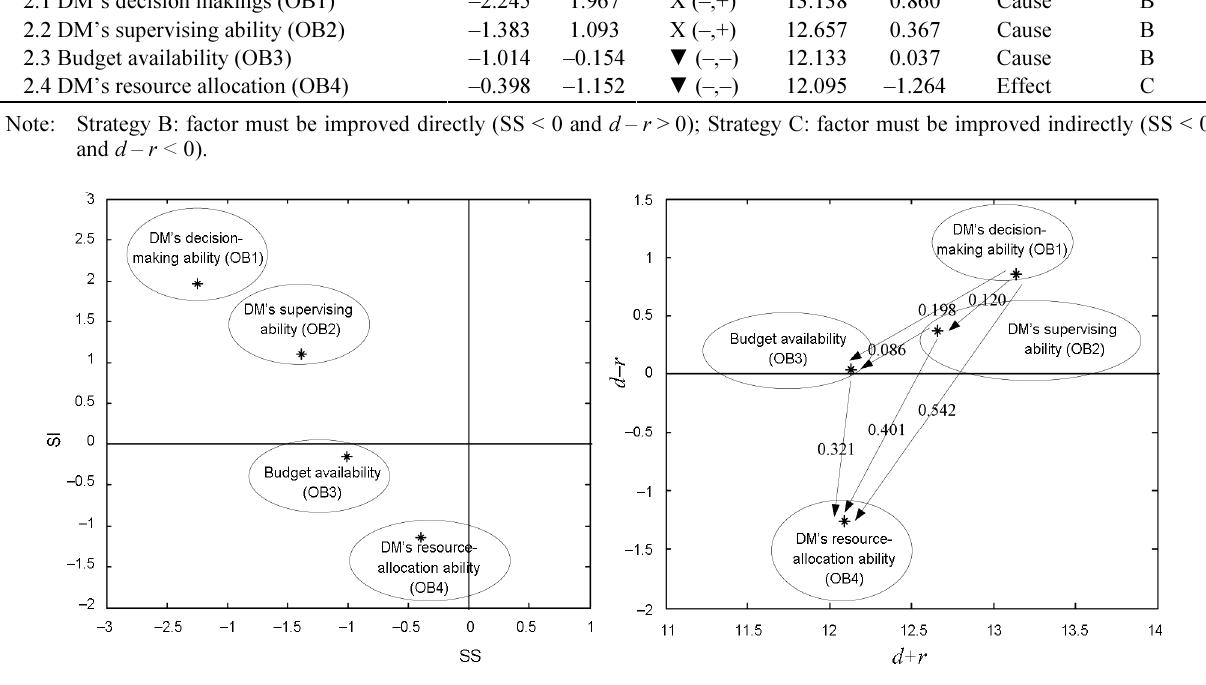
Fig. 6. Integration of ISA and IRM for sub-factors under OB